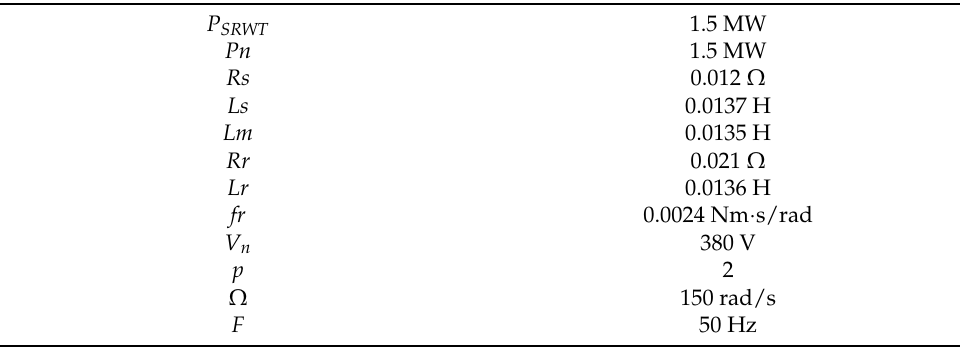
Table A1. The AG parameters